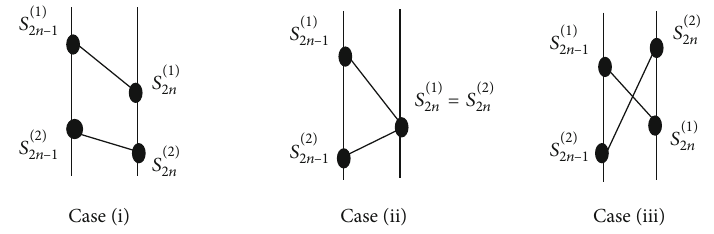
Figure 1: Illustrations of Remark 4.